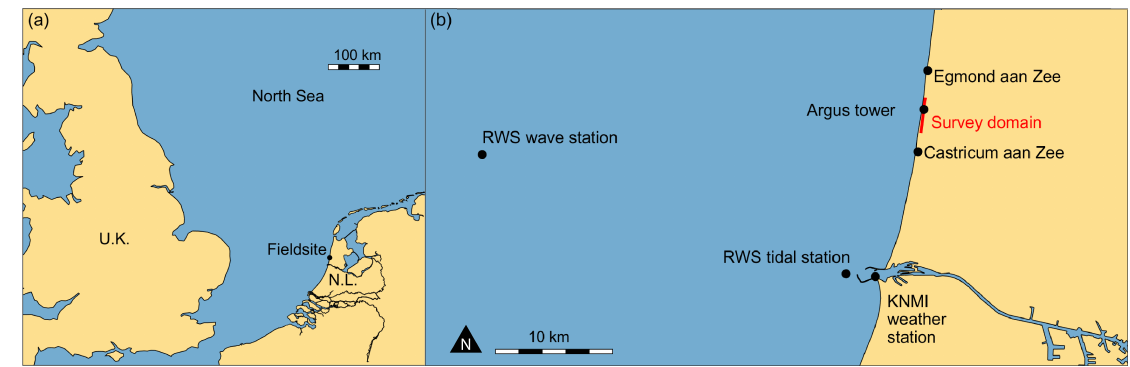
Figure 1. ( a ) Location of the field site with respect to the North Sea basin. ( b ) Location of the survey area, with locations of the Argus Tower (0 point in the local coordinate system), weather station, tidal station and wave station indicated.